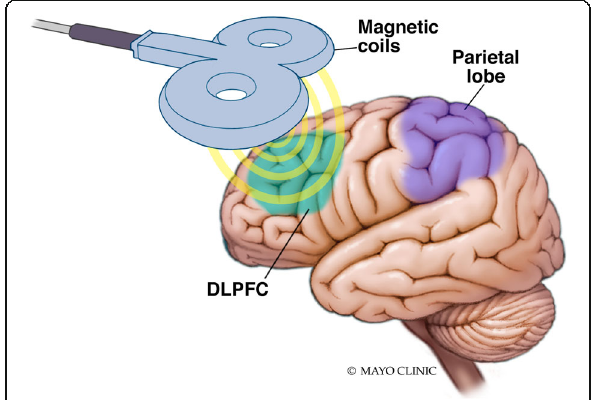
Fig. 1 rTMS -- a noninvasive therapy where magnetic fields are applied on the scalp to create an electrical current in brain tissue to modulate neuronal activity in localized cortical